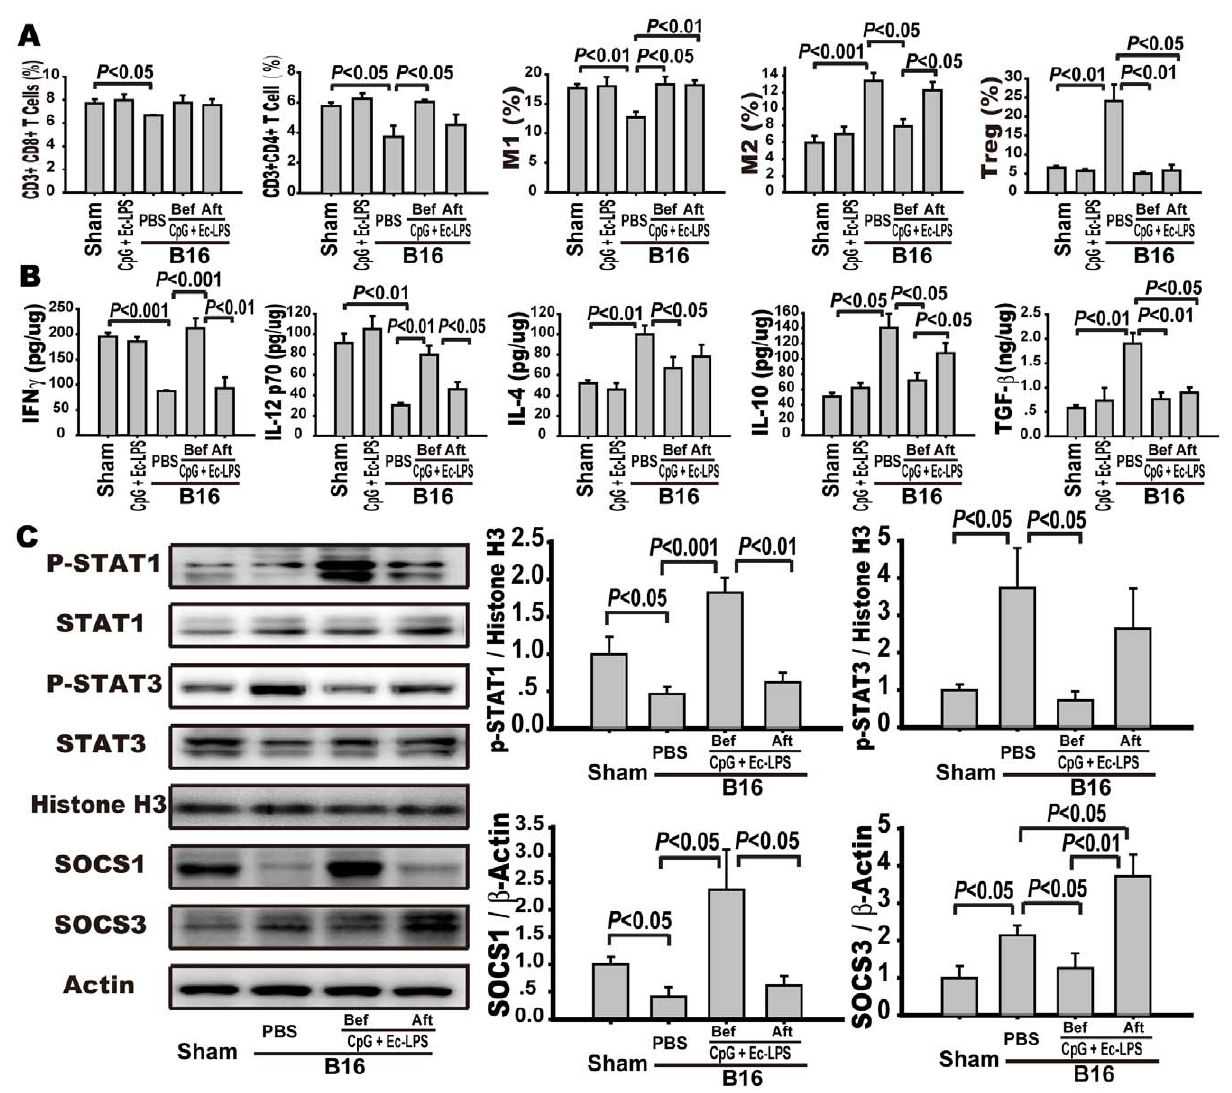
Figure 2. Prophylactic or therapeutic application of the complex differently regulates the inflammatory milieu and STAT1 activation. Mice were treated as indicated in the legend of Figure 1 and sacrificed 14 days after B16 melanoma cell inoculation. Lung single-cell suspensions were prepared as indicated in the Methods. (A) CD3 + CD8 + T cells, CD3 + CD4 + T cells, Foxp3 + CD4 + CD25 + Treg cells, CD11b + F4/80 + CD206 2 M1 and CD11b + F4/80 + CD206 + M2 macrophages were determined by flow cytometry. Data are the mean 6 S.E. (n=5). (B) The levels of antitumor cytokines IFN c and IL-12p70 and suppressive factors IL-4, IL-10, TGF- b were detected in lung homogenates from mice using ELISA kits. Data are the mean 6 S.E. (n=5). (C) The expression of STAT1 and STAT3 singling molecules in the lung tissue. The lungs were excised, and the cytoplasmic and nuclear fractions were extracted as described in the Methods. The expression of p-STAT1, STAT1, p-STAT3, STAT3, and histone H3 in nucleic extracts and SOCS1, SOCS3, and b -actin in the cytoplasm were detected with Western blotting. Left panel is representative western blots and right panels are summary results. Data are presented as the mean 6 S.E. of five mice per group.